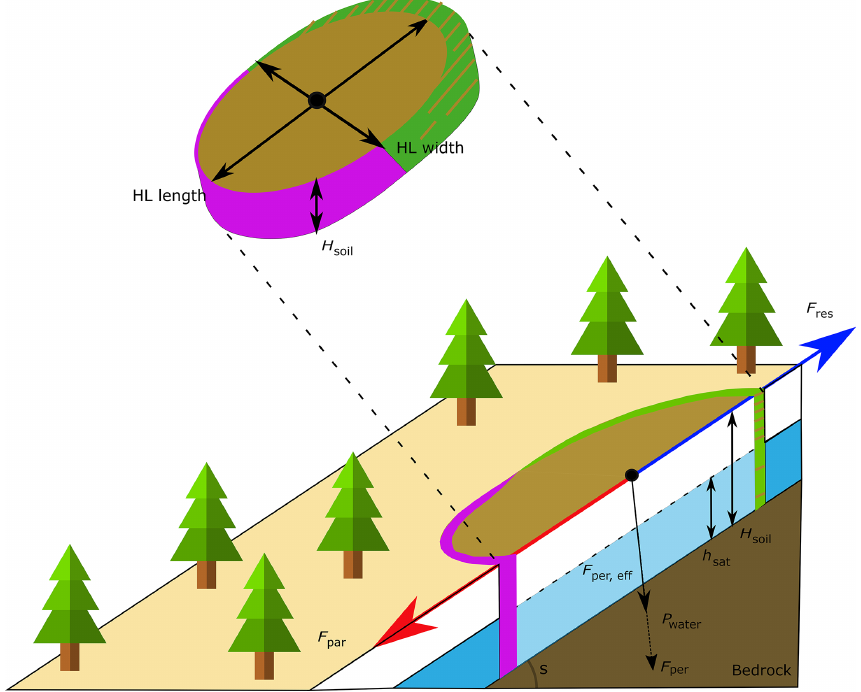
Figure 2. Schematic overview of the forces acting upon a hypothetical landslide, as assumed in SlideforMAP. The blue arrow, F res , indicates the stabilizing forces, and the red arrow, F par , indicates the destabilizing forces. Lateral root reinforcement only acts upon the green part of the hypothetical landslide, where tension takes place. In purple is the compression zone in the shallow landslide. Basal root reinforcement and soil shear strength act on the whole potential failure